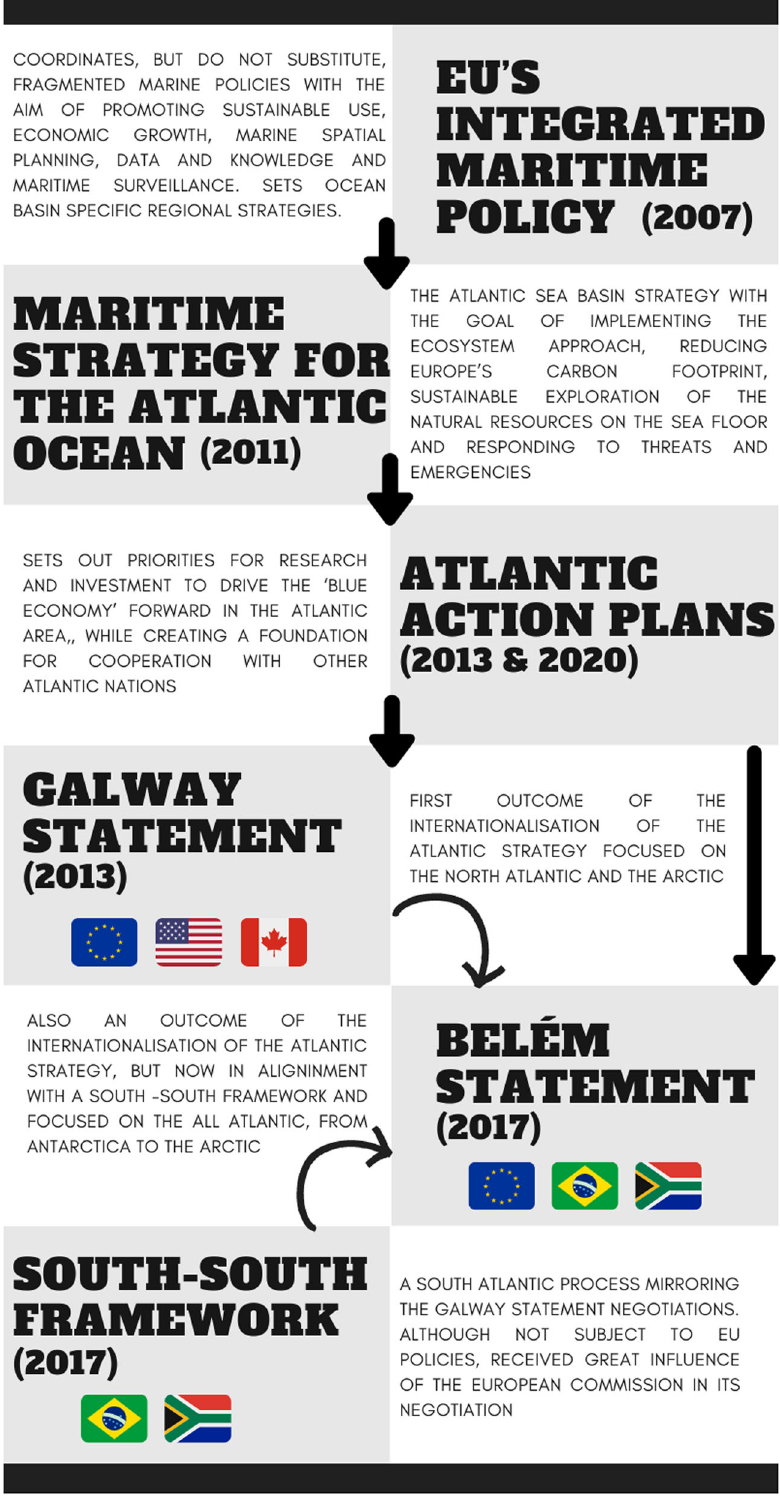
Fig. 1 EU ’ s strategic framework in support of the All Atlantic Ocean Research Alliance. This fi gure is covered by the Creative Commons Attribution 4.0 International License. Reproduced with permission from Andrei Polejack; copyright © Andrei Polejack, all rights